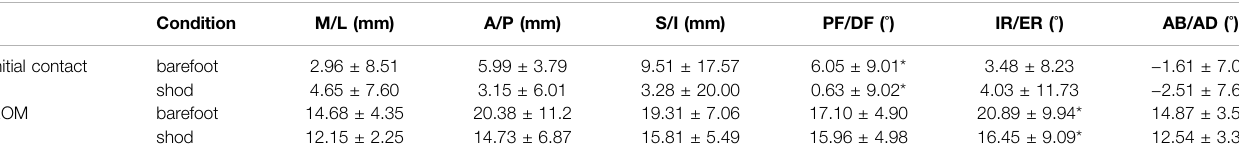
*:comparedwithbarefoot,signi fi cantdifferencesexistedintheshodcondition, p < 0.05.M/L,medial/lateraltranslation;A/P,anterior/posteriortranslation;S/I,superior/inferiortranslation; PF/DF,plantar fl exion/dorsi fl exion;IR/ER,inversion/eversion;AB/AD,abduction/adduction;ROM,rangeofmotion; “ + “ :the fi